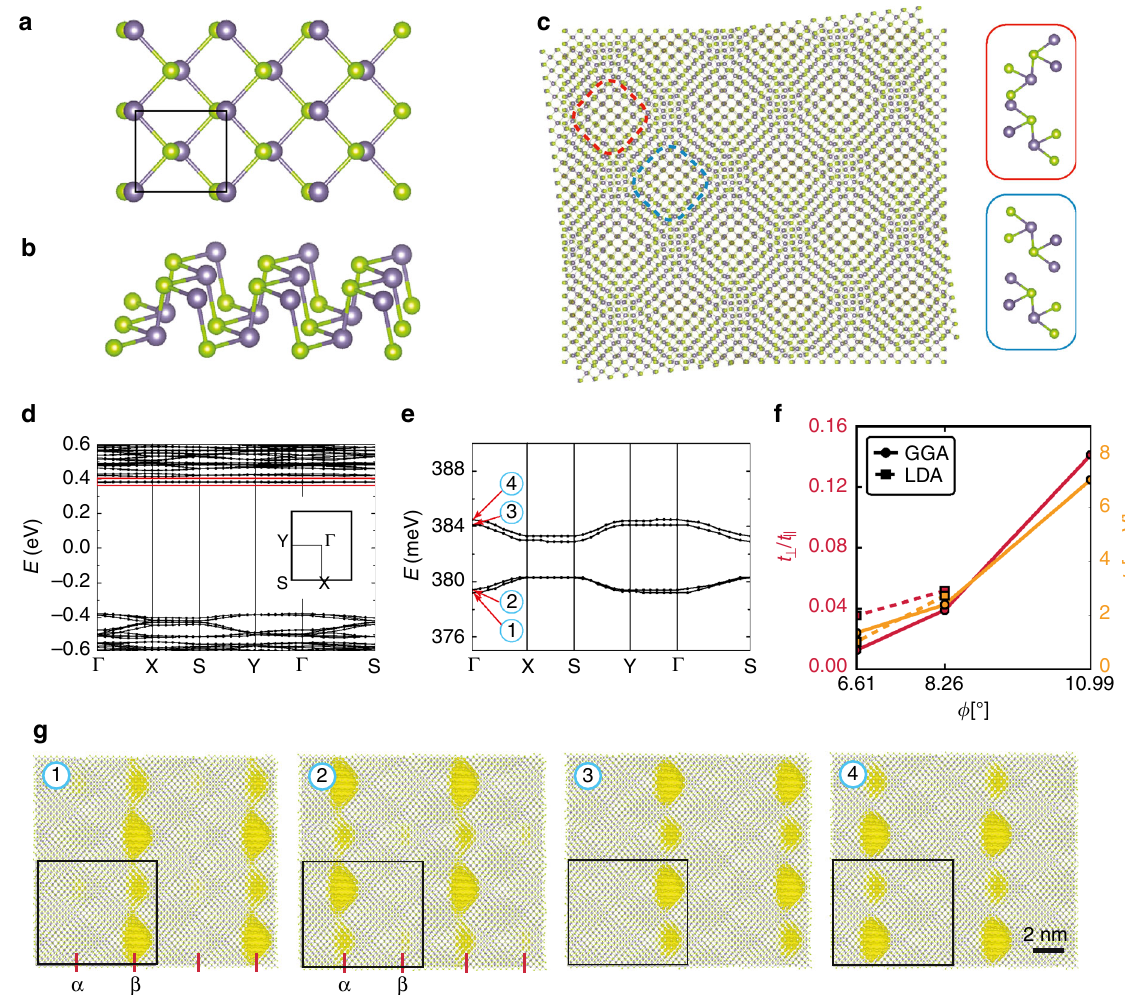
Fig. 1 Ab initio characterization of twisted bilayer GeSe. a , b Top and side view of monolayer GeSe. Green and blue spheres indicate Se and Ge atoms, respectively. The black box in the top panel denotes the rectangular unit cell of the system. c moiré pattern for two sheets of GeSe stacked at a relative twist of 180-6.61 degree denoted by con fi guration B. The pattern that emerges shows a rectangular shape, with much larger unit cell. We highlight two areas with dashed lines whose staking is given in the right panels. d , e Band structure as obtained from density functional theory using the LDA. Flat bands emerge at the edge of the valence and the conduction bands, where e shows a zoom into the red-boxed region highlighted in d . The fl at bands at the conduction band disperse only along one spatial direction, the Γ ! X and S ! Y direction. f LDA and GGA results for the ratio between inter-wire ( t ? ) and intra-wire ( t k ) couplings of the emergent one-dimensional chains at low energies as a function of twist angle, highlighting the emergence of quasi-one- dimensional physics at small twists. g Real space illustration of the one-dimensionality of the system showing the charge density of the bands labeled by 1 – 4 in e as accumulated yellow regions (the unit cell hosts a pair of wires with a staggered chemical potential and a wire-wire coupling that vanishes as the angle is decreased). The charge density wires are highlighted with red lines and annotated by α and β the fi t, as well as the crossover from two dimensions to one can be found in the Methods section.